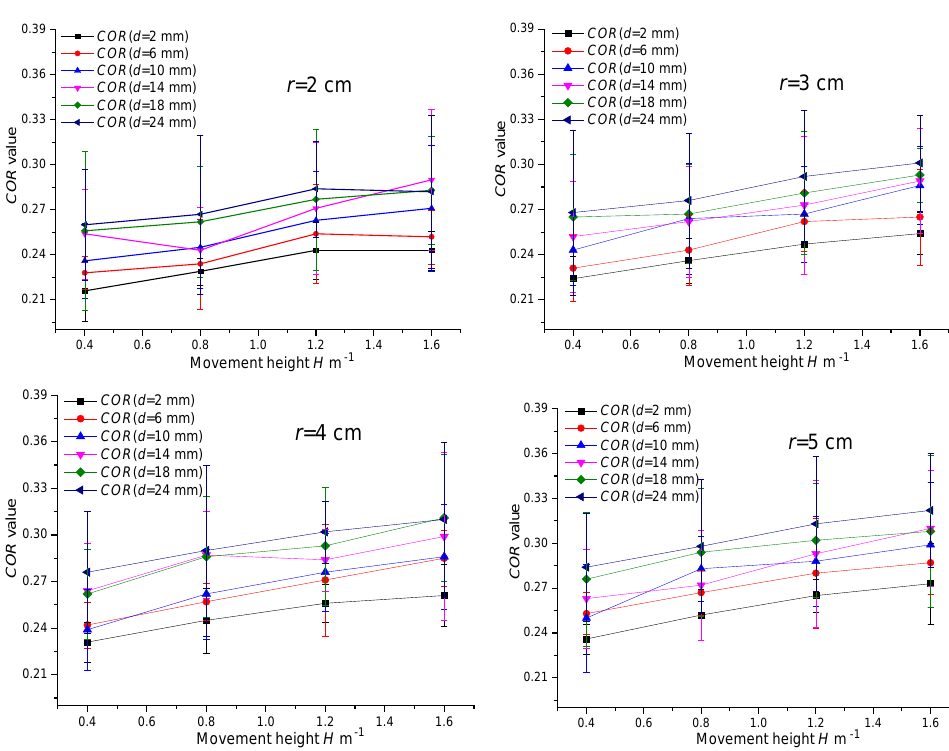
Figure 7. Comparison of the COR for blocks of different radii colliding with an 8cm thick cushion.